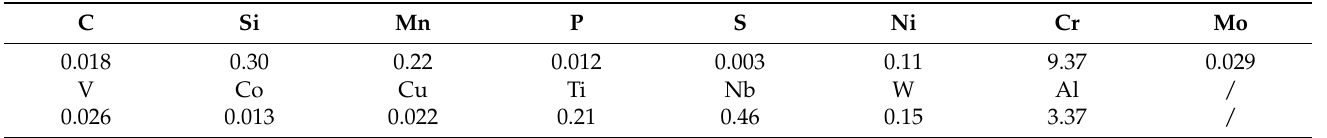
Table 5. Elementary composition of the melt zone (wt.%).